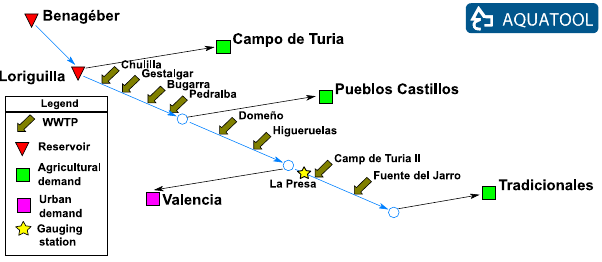
Figure 1. Location of Turia River (right) in the Jucar River Basin (Source: http://www.chj.es).